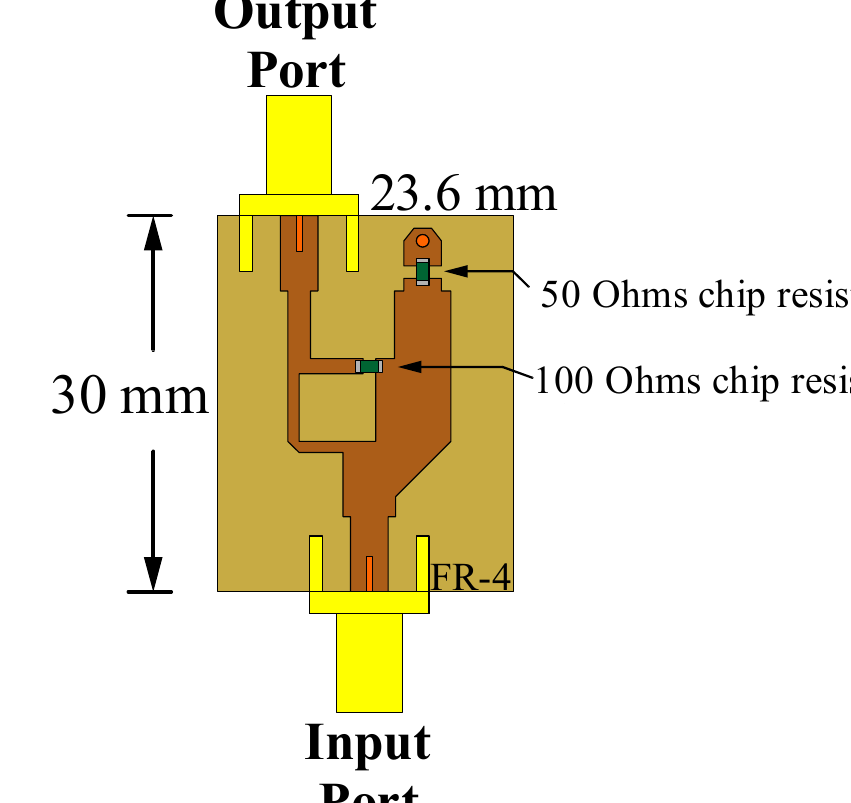
Figure 10. Reflection coefficient for the complete system measured by a vector network analyzer.